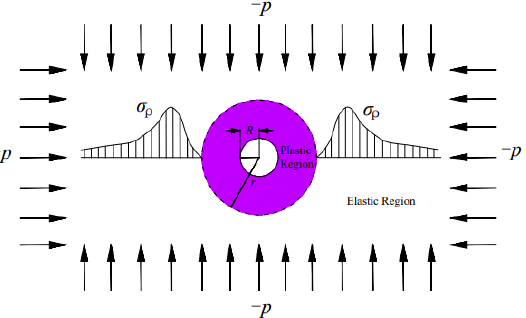
Figure 15. Plastic zone and horizontal radial stress distribution of circular roadway. The above discussions are all single-hole pressure relief, whereas, in actual engineering, multiple boreholes are used to relieve pressure together, so it is necessary to discuss the influence of borehole spacing on the pressure relief effect. Taking two boreholes with the same diameter and depth as an example, when the plastic zone formed between the boreholes begins to connect, the strain energy changes fastest and the pressure relief effect changes most obviously [9]. Based on this, in the case of the same diameter and depth of the two boreholes, the radius of the plastic zone of the single borehole is obtained, and then the maximum spacing between the plastic zones of the two boreholes is determined, as shown in Figure 16 (the stress is positive in tension and negative in compression). The parameter values measured by the non-porous test block are p = σ 1 = σ c = 19.231 MPa, the cohesion of the rock c = 0.5 MPa, and the internal friction angle θ = 27 ◦ . Substituting the measured parameter values into Equation (4) to calculate the radius of the single-hole plastic zone, r = 4.286 R m, and then the distance between the two boreholes should not be less than ∆ d = 2 r − 2 R = 6.572 R . As the hole radius set by the borehole spacing in the laboratory test is R = 0.5 cm, it is calculated that when the spacing between the two boreholes 3.286 cm ≥ ∆ d, the plastic zone around the hole is connected, and vice versa.